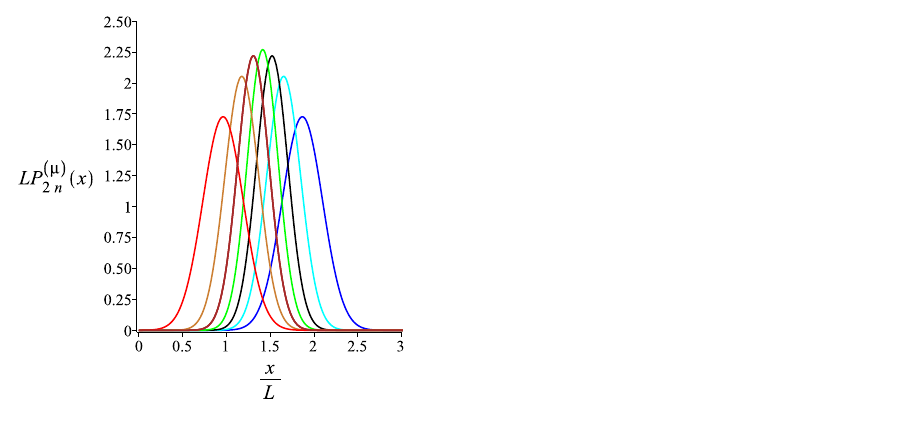
Figure 9. The probability density of the x component of the position of the free endpoint of the structure with an even number of arms. The red, gold, brown, green, black, cyan, and blue are associated with the fixed values of the orientation of the external magnetic field, φ B = − ω − π where i = 0,1,2,3,4,5,6, respectively. The other fixed parameters are: ω = π n = 1, and K B = 4.